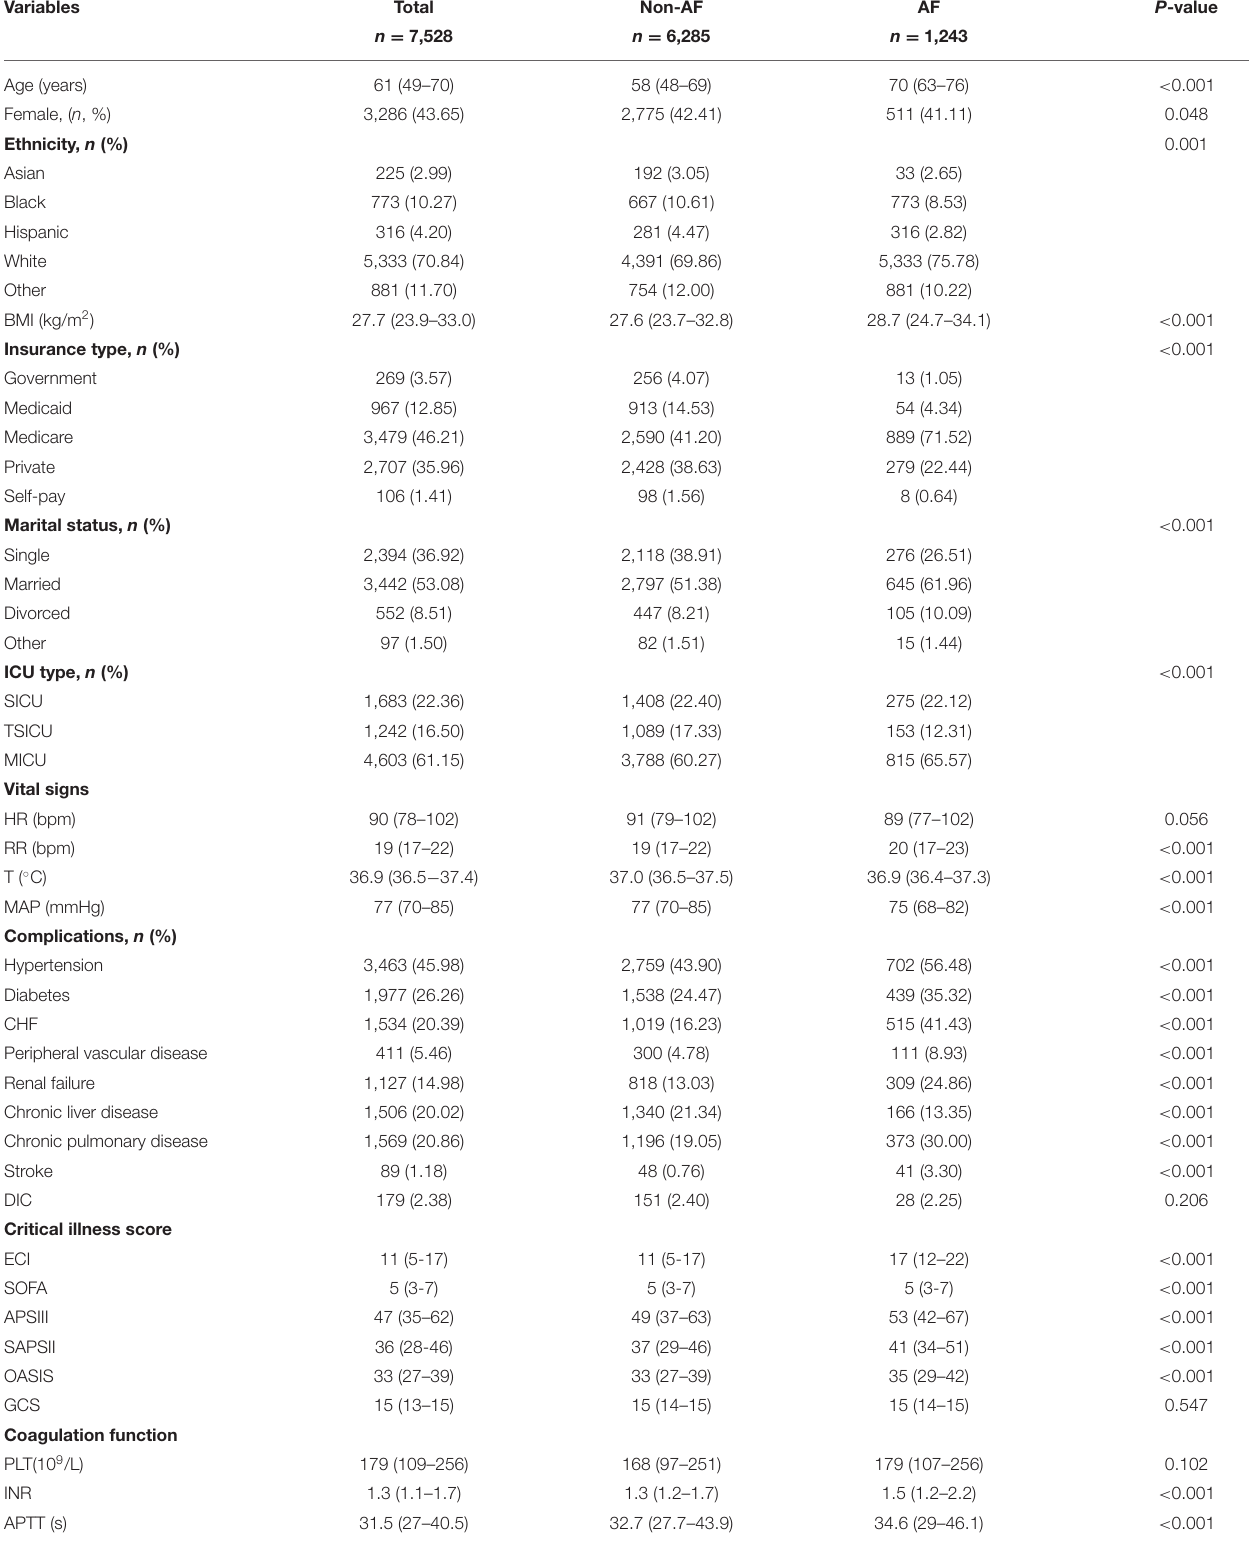
TABLE 1 | Demographic characteristics between AF and Non-AF groups within the first 24h after admission to ICUs before PSM.